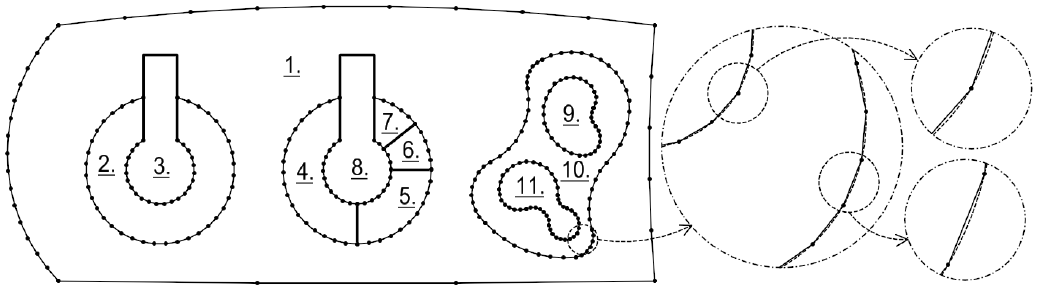
Figure 10. Test object approximated by the new algorithm.